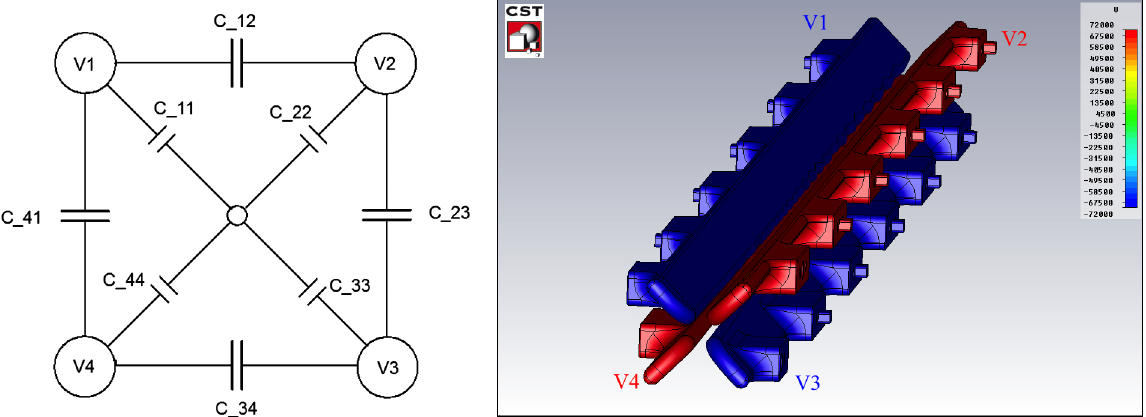
FIG. 8 (color online). For the purpose of calculating C with EMS, we have set one pair of electrodes to 72 kV (red) and another pair to − 72 kV (blue). From here, we can extract the lumped capacitance matrix to calculate C